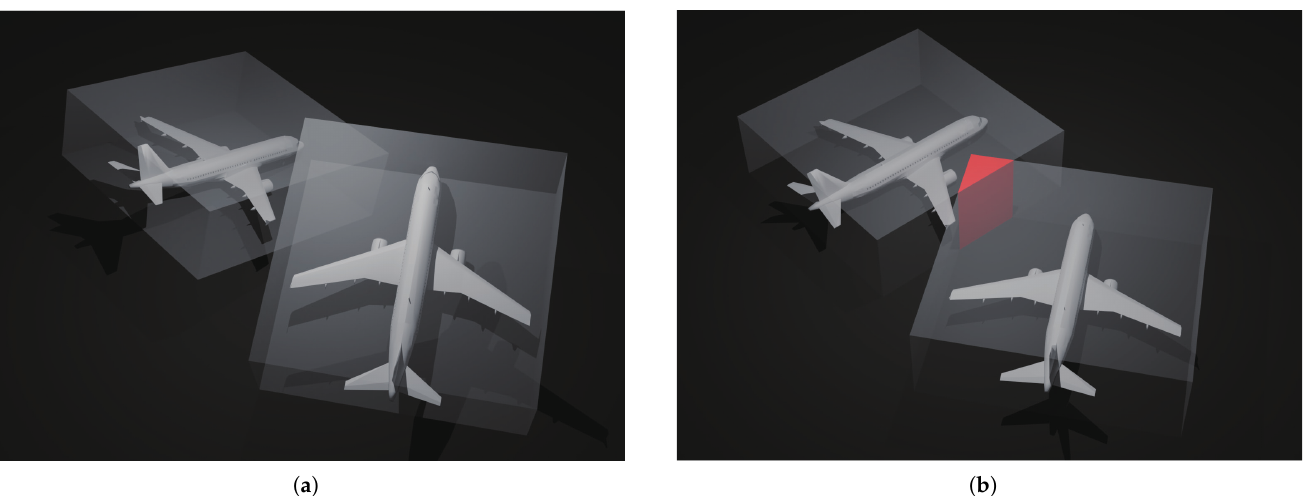
Figure 8. Examples of the intersection space of circumscribed cuboids of two aircraft A320. ( a ) The aircraft on the left is descending, whereas the aircraft on the right is climbing. The circumscribed cuboids of the two aircraft do not intersect. ( b ) Both aircraft are in level flight. Although the circumscribed cuboids of these two aircraft intersect (marked in red), the actual aircraft shapes do not intersect. Therefore, these two aircraft do not collide with each